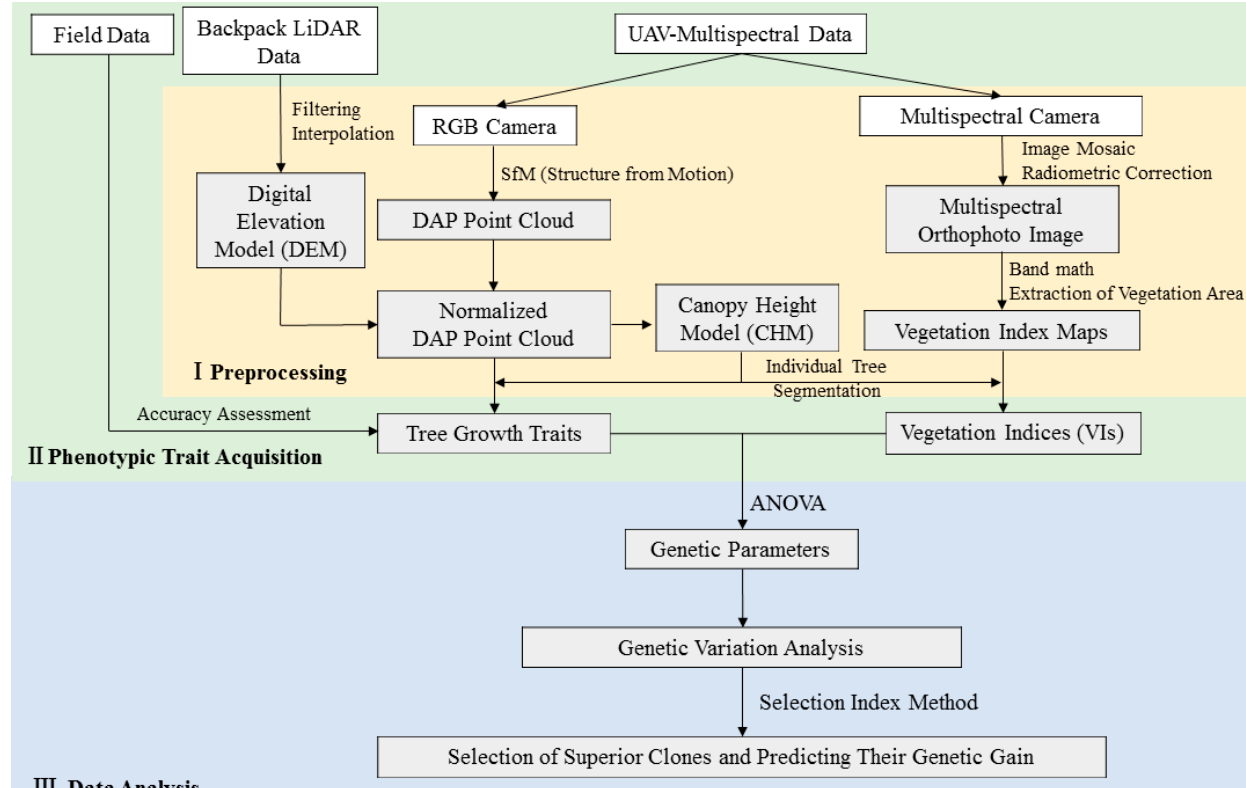
Figure 1. Overview of the analysis workflow in this study.